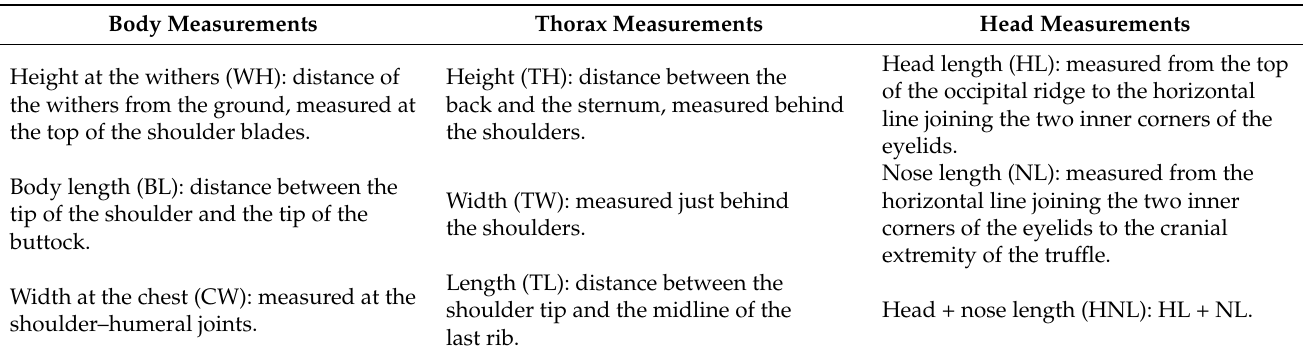
Table 1. Morphometric measurements, body indexes, and reference points